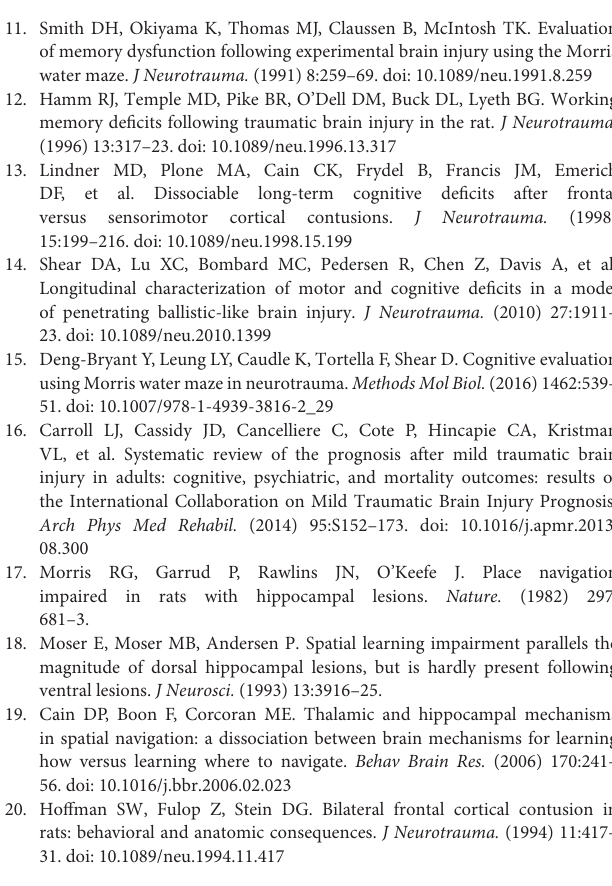
Supplement Figure 1 | Higher magnification of silver staining in the corpus callosum. Silver staining indicates elevated levels of axonal degeneration in